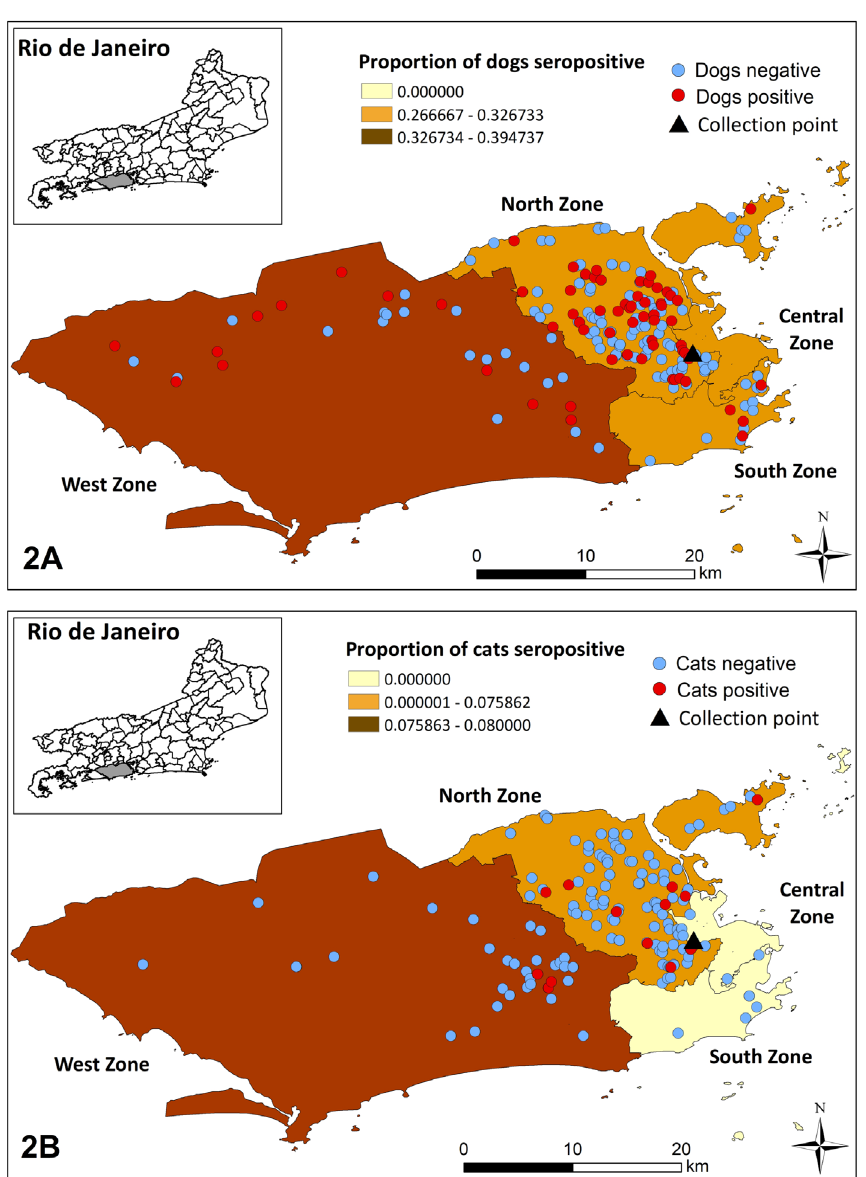
Figure 2. Spatial distribution of domiciled dogs (A) and cats (B) and proportion of T. gondii- seropositive animals by areas of Rio de Janeiro city. Table 1. Frequencies of T. gondii- seropositive domestic dogs and cats by geographical region of Rio de Janeiro city treated at the Municipal Institute of Veterinary Medicine Jorge Vaitsman from August 2017 to January 2020. Geographical area in Dogs Rio de Janeiro city Central